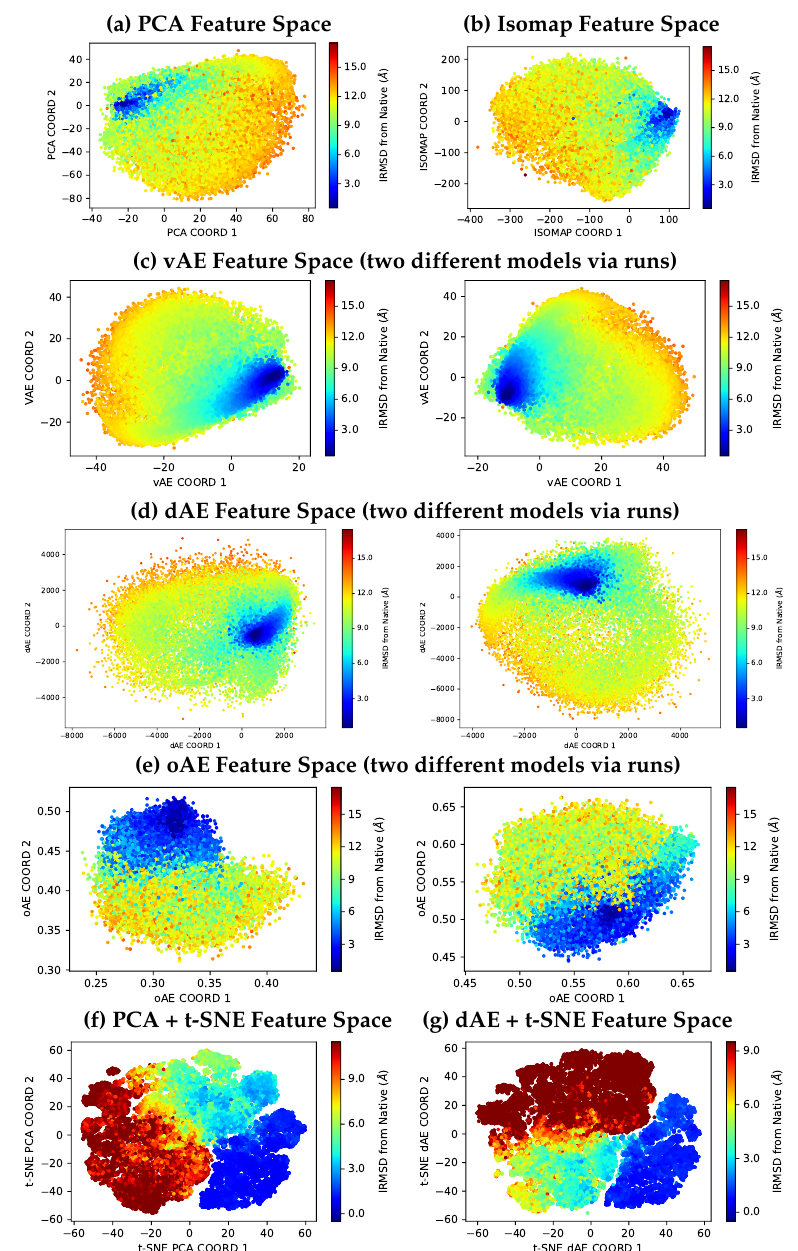
Figure 2. Tertiary structures obtained with Rosetta and prepared for input as described in Section 3 are projected onto the two features learned via ( a ) PCA, ( b ) Isomap, ( c ) best-performing vAE architecture, ( d ) best-performing dAE architecture, ( e ) best-performing oAE architecture, ( f ) PCA + t-SNE, or ( g ) best-performing dAE model + t-SNE; in ( c – e ), two feature spaces are shown to demonstrate the variability of model parameters converged onto from the learning process. ( a – g ) Featurized structures are drawn as disks, color-coded by their lRMSD (of the corresponding CA-represented structures) from the native structure in a blue-to-red color scheme indicating lower-to-higher